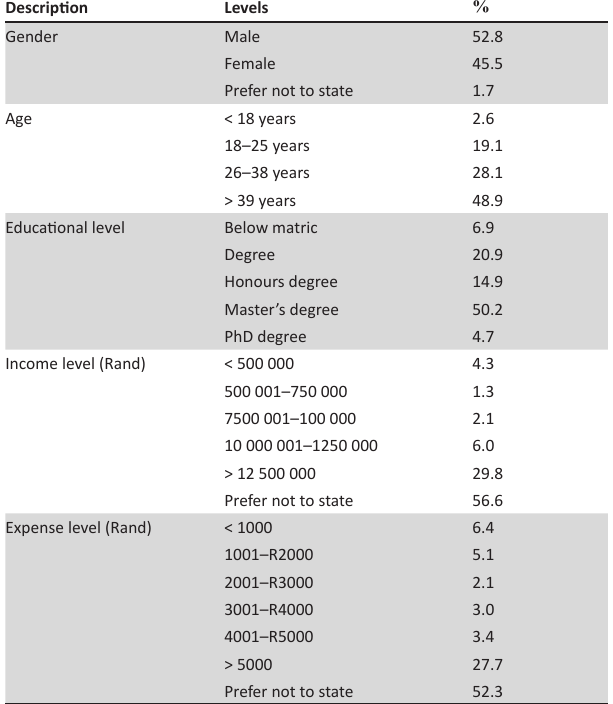
TABLE 3: Cronbach’s alpha, composite reliability and average extracted values.